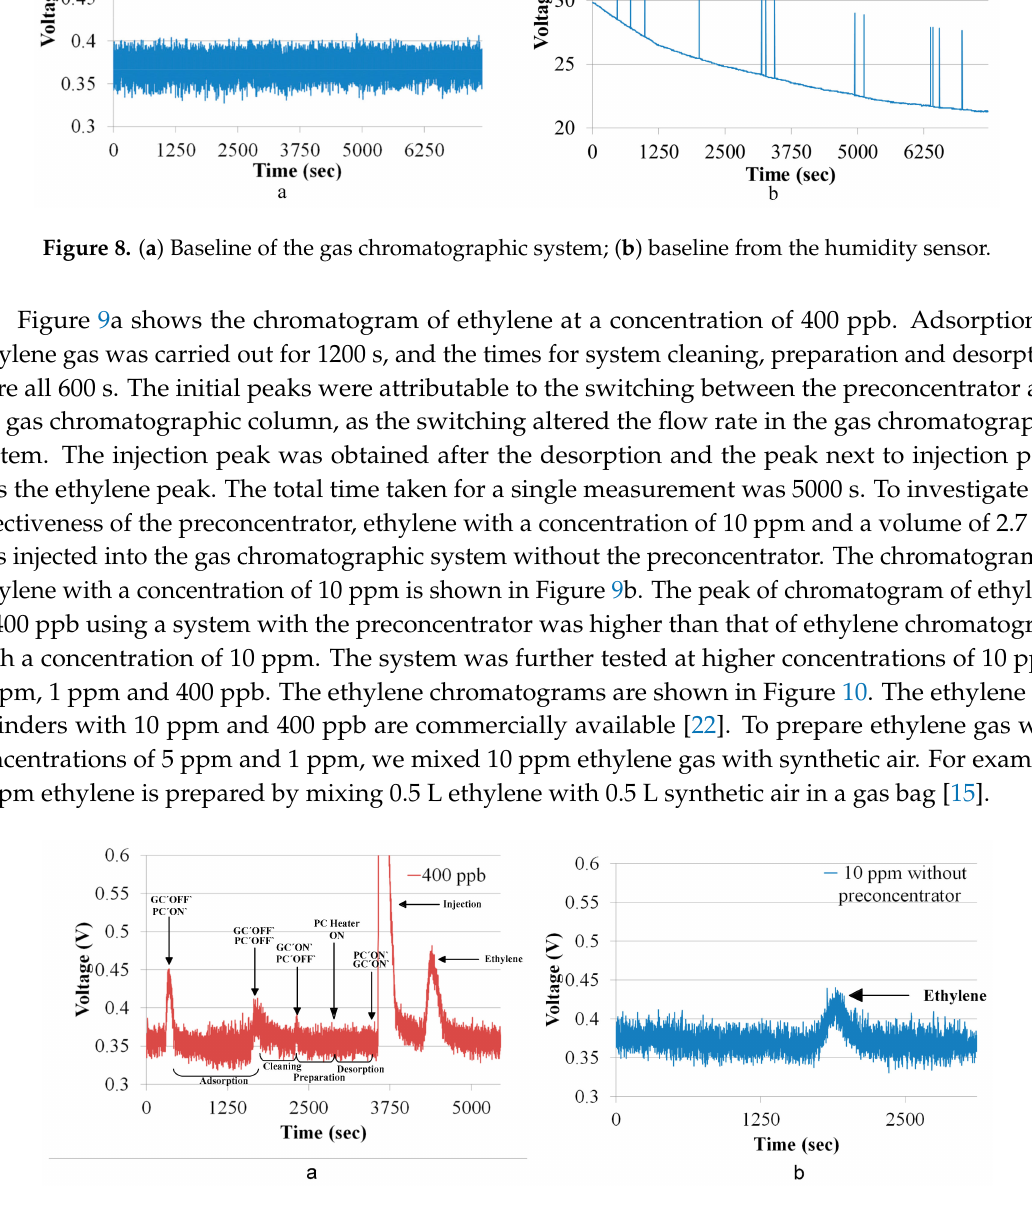
Figure 9. ( a ) Chromatogram of ethylene at 400 ppb; ( b ) chromatogram of ethylene at 10 ppm without the